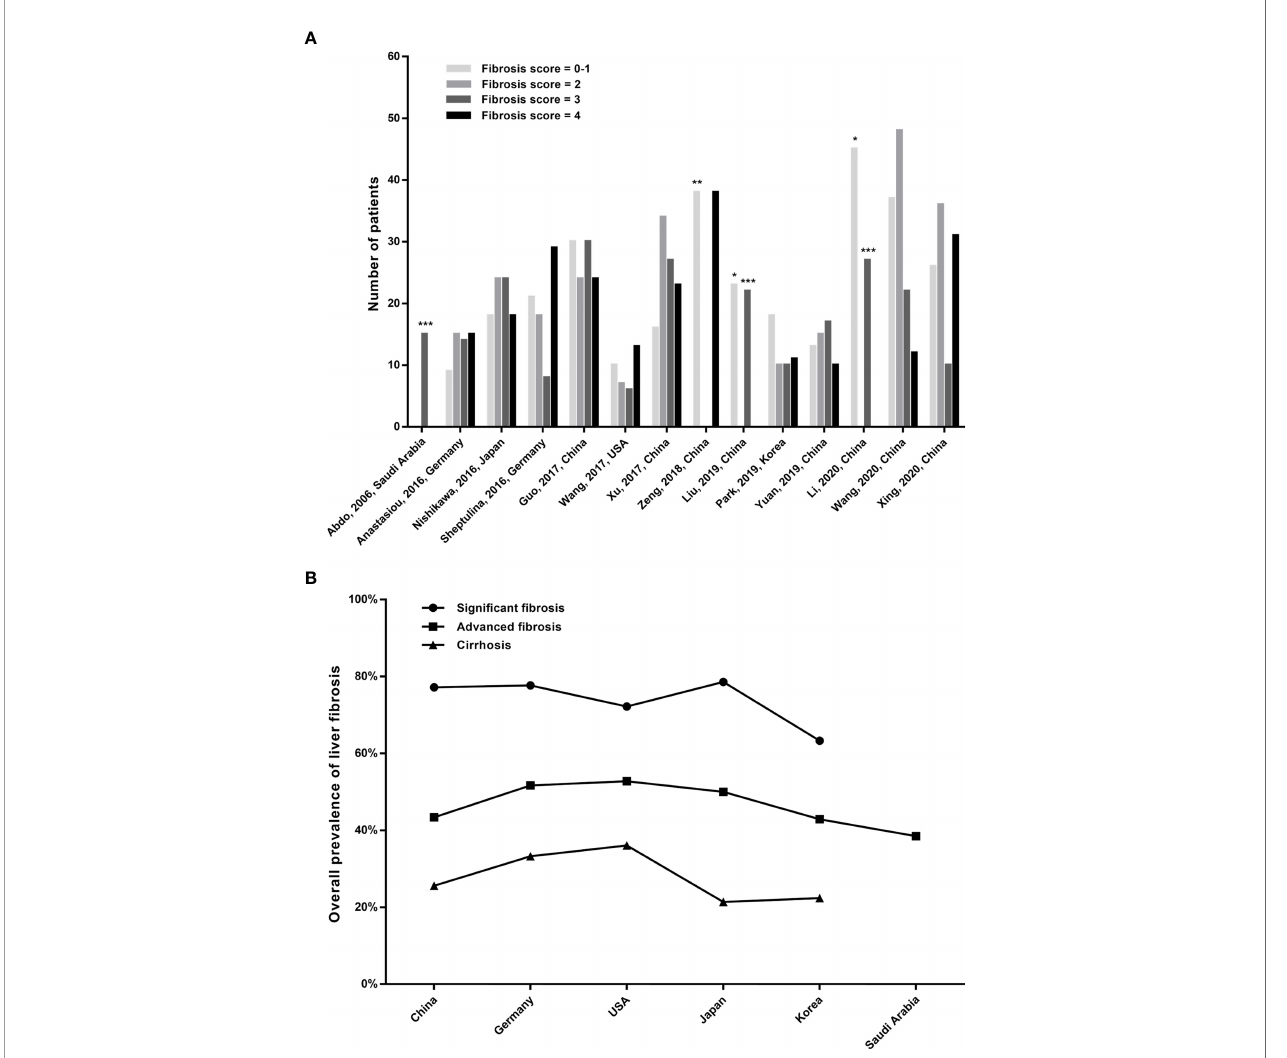
FIGURE 2 | (A) Distribution of liver fi brosis stages in AIH patients of the included studies. * The columns represent fi brosis stage of 0-2; ** the column represents fi brosis stage of 0-3; and *** the columns represent fi brosis stage of 3-4. (B) The overall prevalence of fi brosis stages between the included